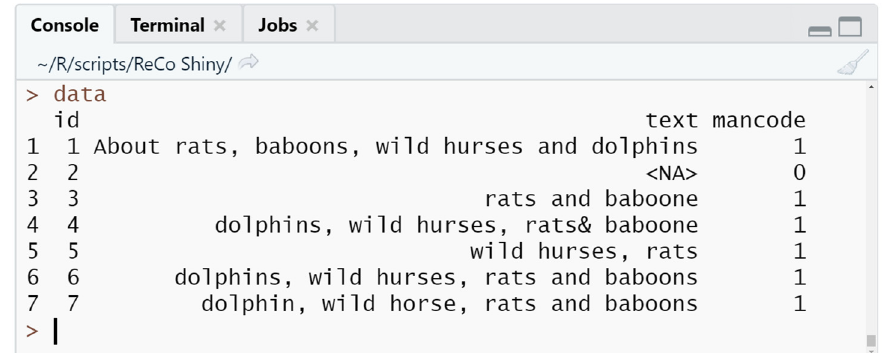
Figure 7. Demo responses.